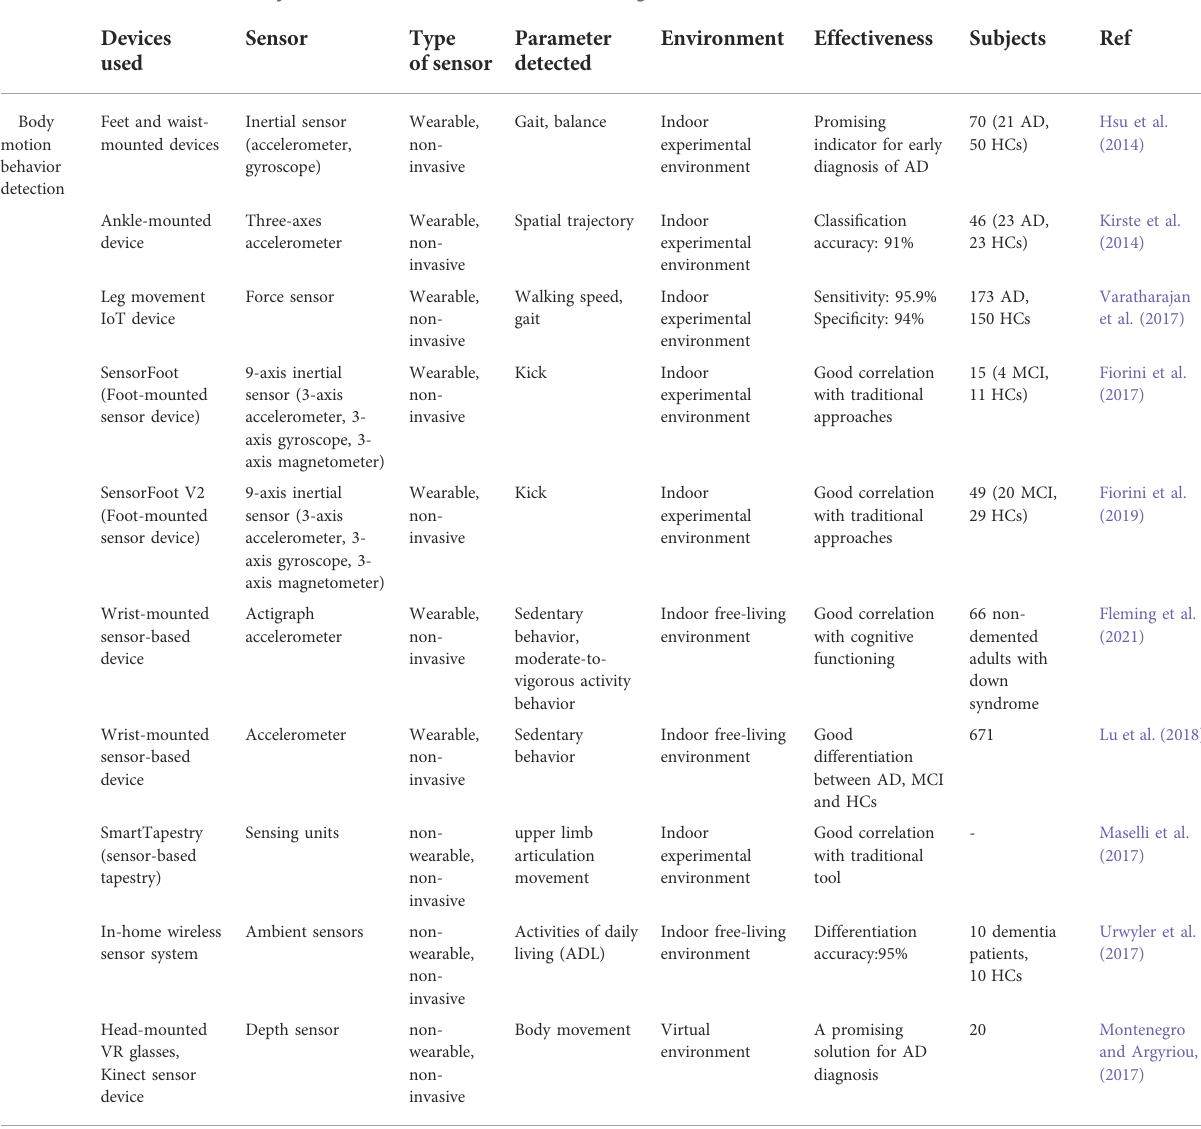
TABLE 1 List of sensor-based body motion behavior detection toward AD